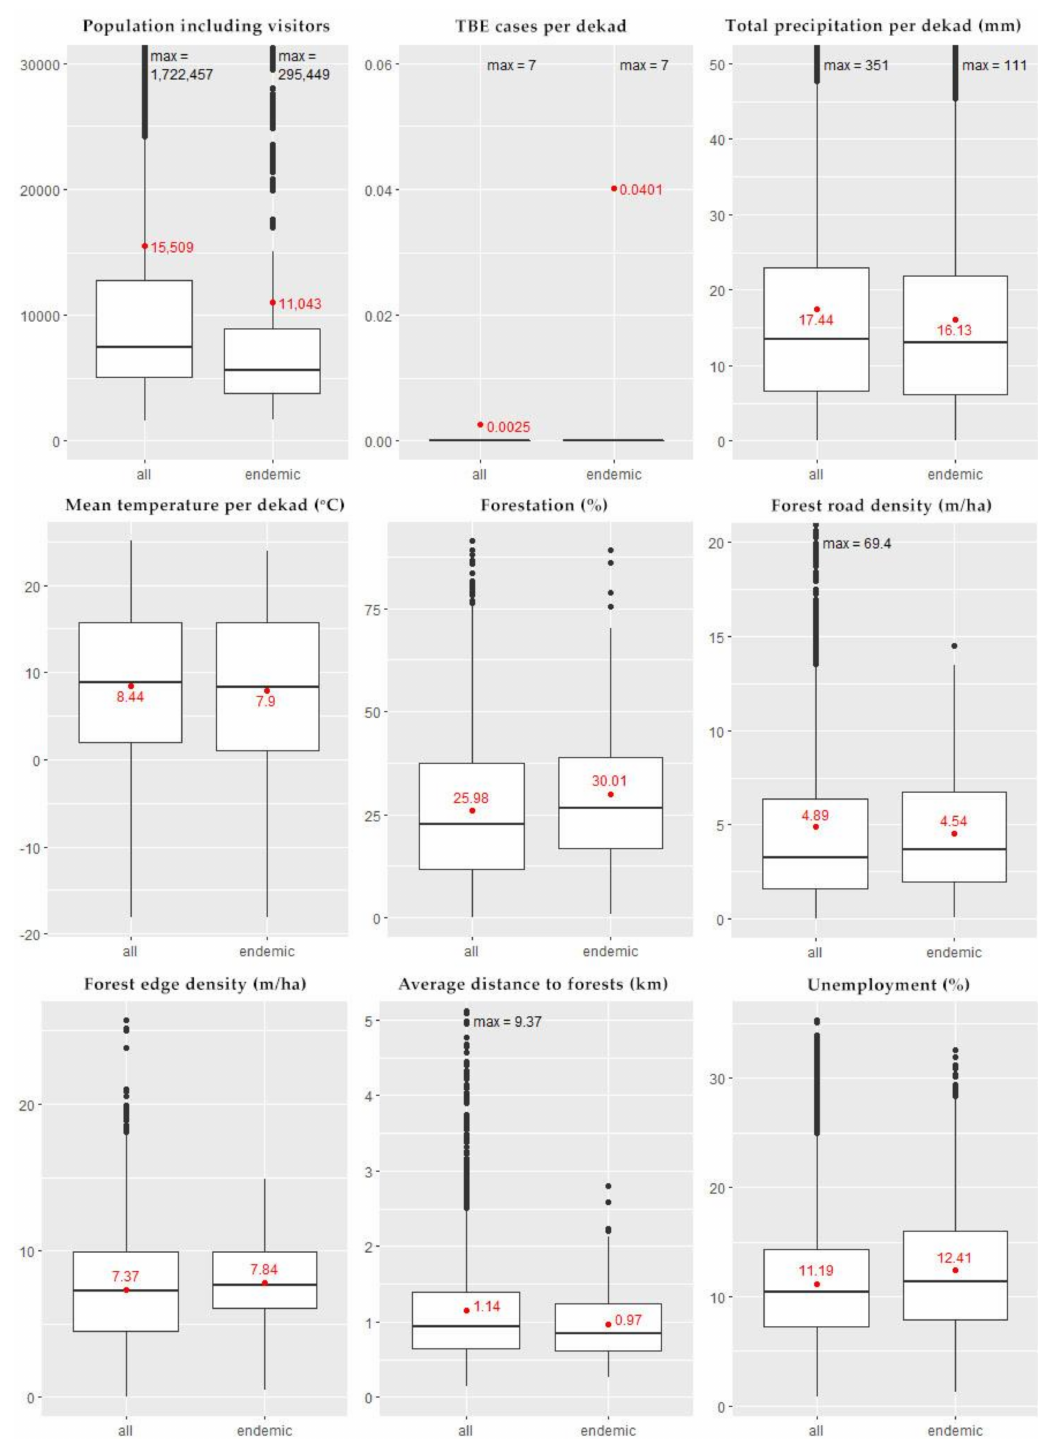
Figure 3. Box plots displaying the distribution of selected variables, comparing the area included in the model building (108 endemic municipalities) and the entire country territory, Poland, 1999–2012. The middle bars of the boxes show the median, and the red dots with the accompanying numbers display the mean